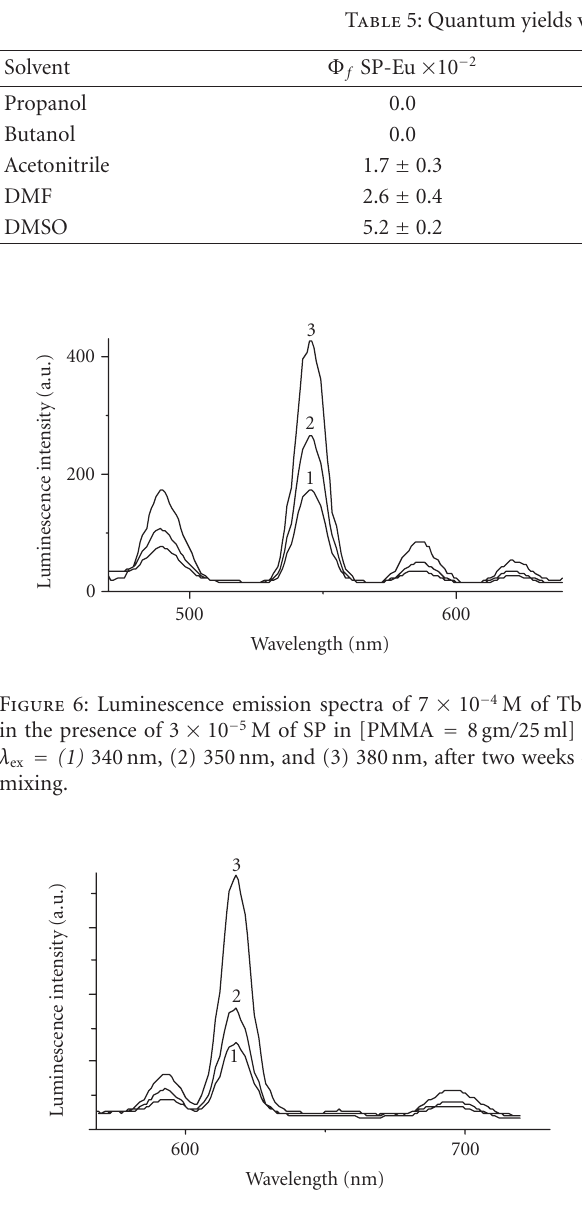
Figure 7: Luminescence emission spectra of 3 × 10 − 4 M of Eu 3+ in the presence of 3 × 10 − 5 M of SP in [PMMA = 8gm / 25ml] at λ ex = (1) 340nm, (2) 350nm, and (3) 380nm, after two weeks of mixing.